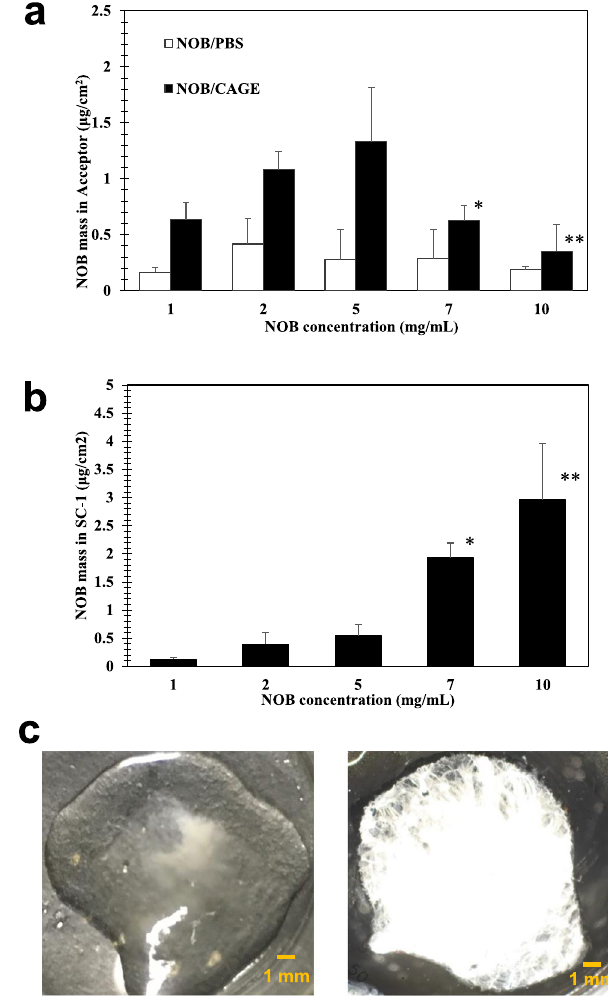
Figure 4. Effect of the NOB concentration in CAGE on the NOB permeation from the skin. ( a) The amount of NOB detected in the acceptor for each concentration of NOB/PBS and NOB/CAGE. ( b) The amount of NOB detected in the SC-1 fraction for each concentration of NOB/CAGE. c) The images of a donor sample of 7 mg/mL NOB/CAGE in FDC after 24 h incubation taken by a camera (left) and by a polarization microscope (right). For both a) and b) , each column represents the mean ± S.D. ( n = 3). The inter-group comparison was carried out using the non-repeated measures ANOVA followed by the Bonferroni test. * and ** Indicate a significant difference ( * P < 0.05, ** P < 0.01) compared with ( a) 5 mg/mL NOB/CAGE or ( b) 5 mg/mL